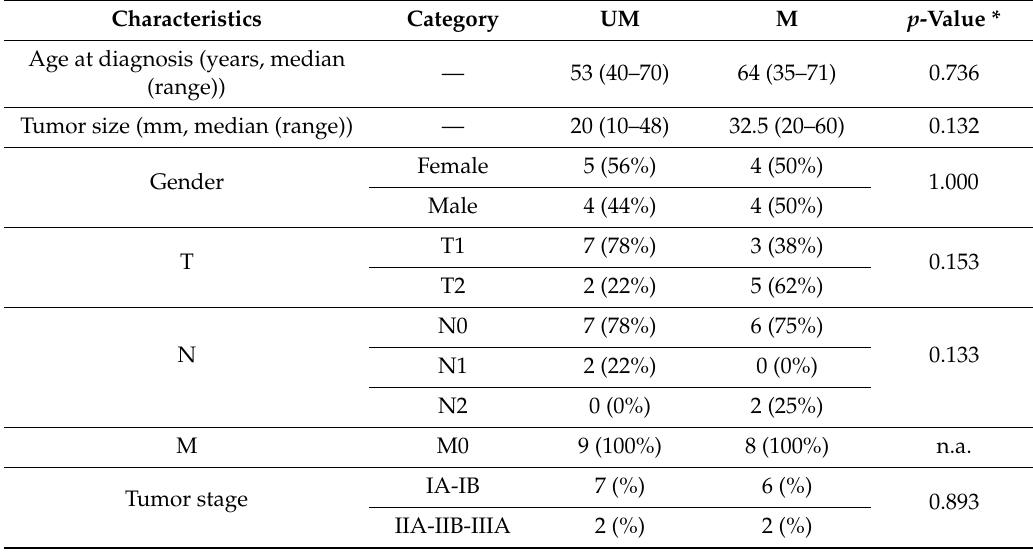
Table 4. Clinical pathological characteristics for patients with atypical carcinoid ( n = 17), according to their KEAP1 methylation